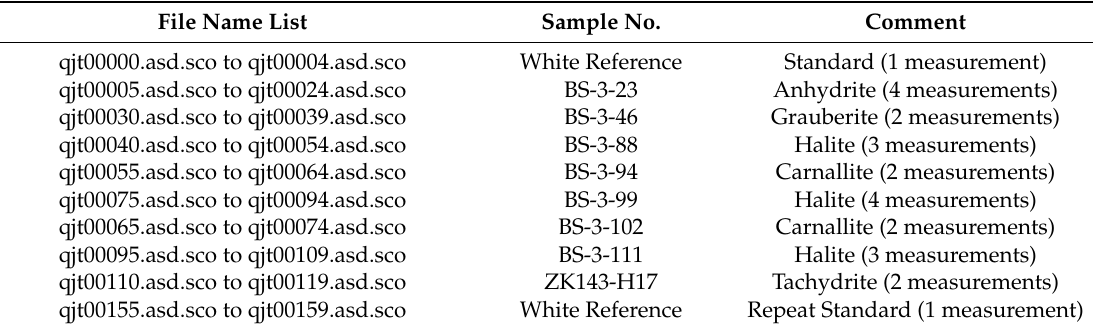
Table 5. Summary of mineral absorption peaks from this study, and reference samples from the USGS spectral library.